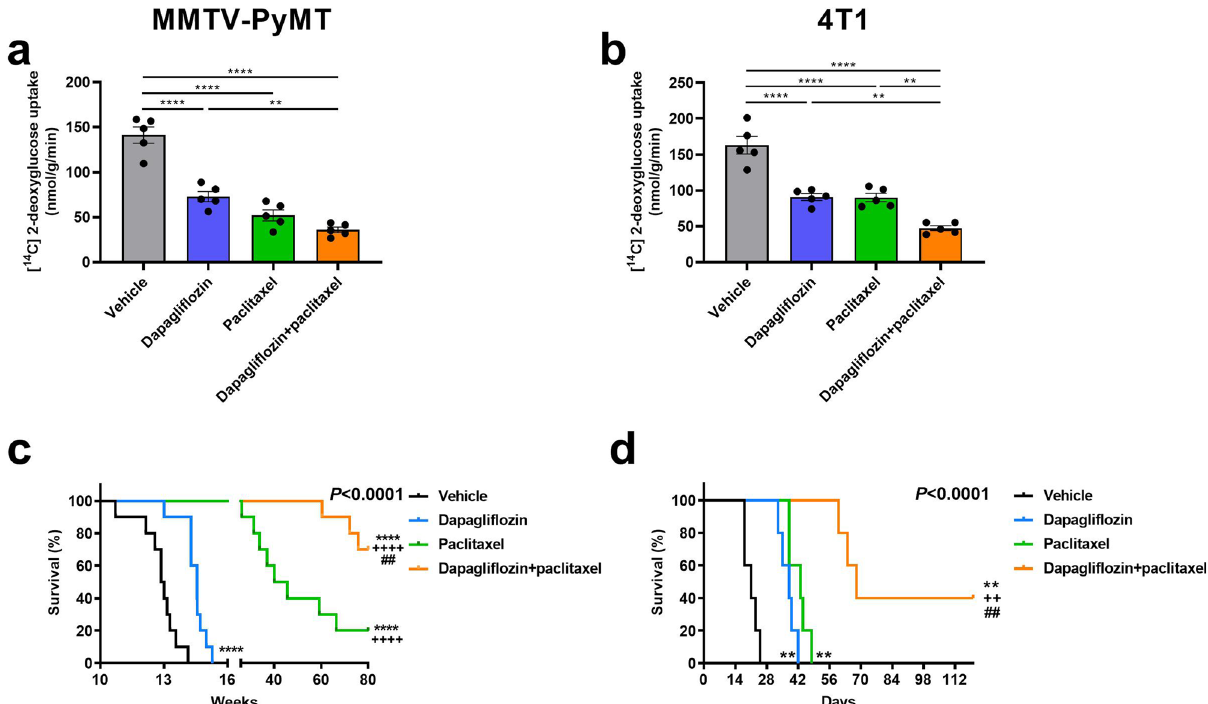
Fig. 4 Dapagli fl ozin enhances the ef fi cacy of chemotherapy in two murine models of breast cancer. Tumor glucose uptake in ( a ) MMTV-PyMT and ( b ) 4T1 tumor-bearing mice. In panels ( a , b ), ** P < 0.01, **** P < 0.0001. c Survival in MMTV-PyMT mice. The x-axis refers to weeks of life. d Survival in 4T1 tumor-bearing mice. The x axis refers to days after tumor cell injection. In panels ( c , d ), ** P < 0.01, **** P < 0.0001 vs. vehicle, ++ P < 0.01, ++++ P < 0.0001 vs. dapagli fl ozin, ## P < 0.01 vs. paclitaxel via the Mantel-Cox log-rank test, adjusted for multiple comparisons. The p values in the upper right corner of each survival curve refer to the overall curve comparison using the Mantel-Cox log-rank test. Glucose uptake was measured in n = 5 per group, and groups of 10 ( c ) and 5 ( d ) were studied to generate the survival